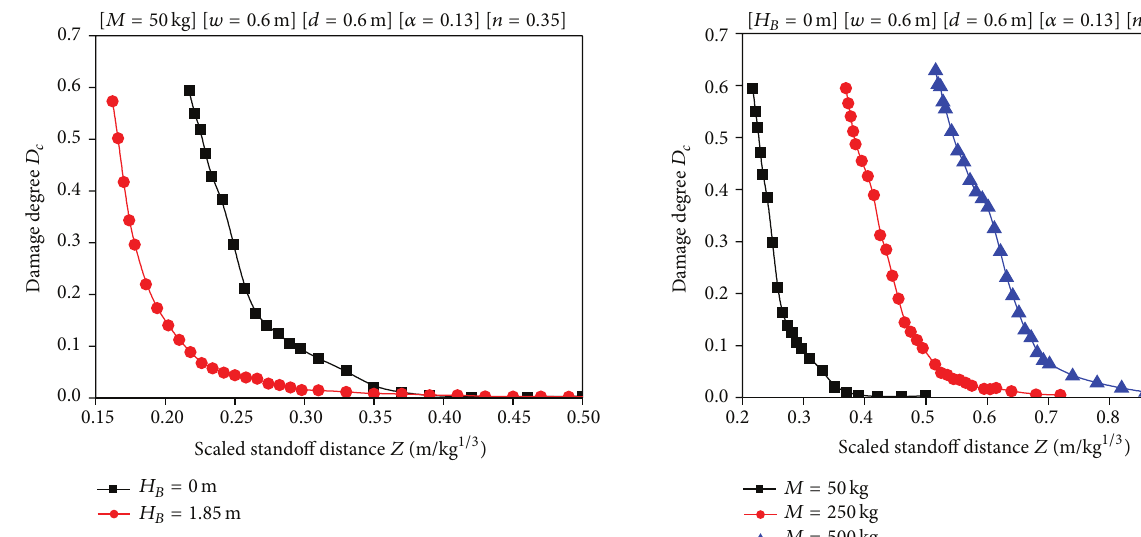
Figure 11: Effects of explosive mass on the damage degree.